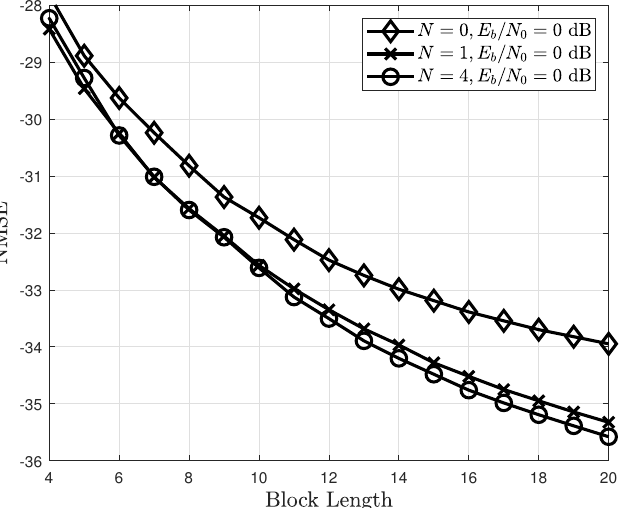
Figure 8. NMSE of the proposed channel estimator based on the number of backup samples N .